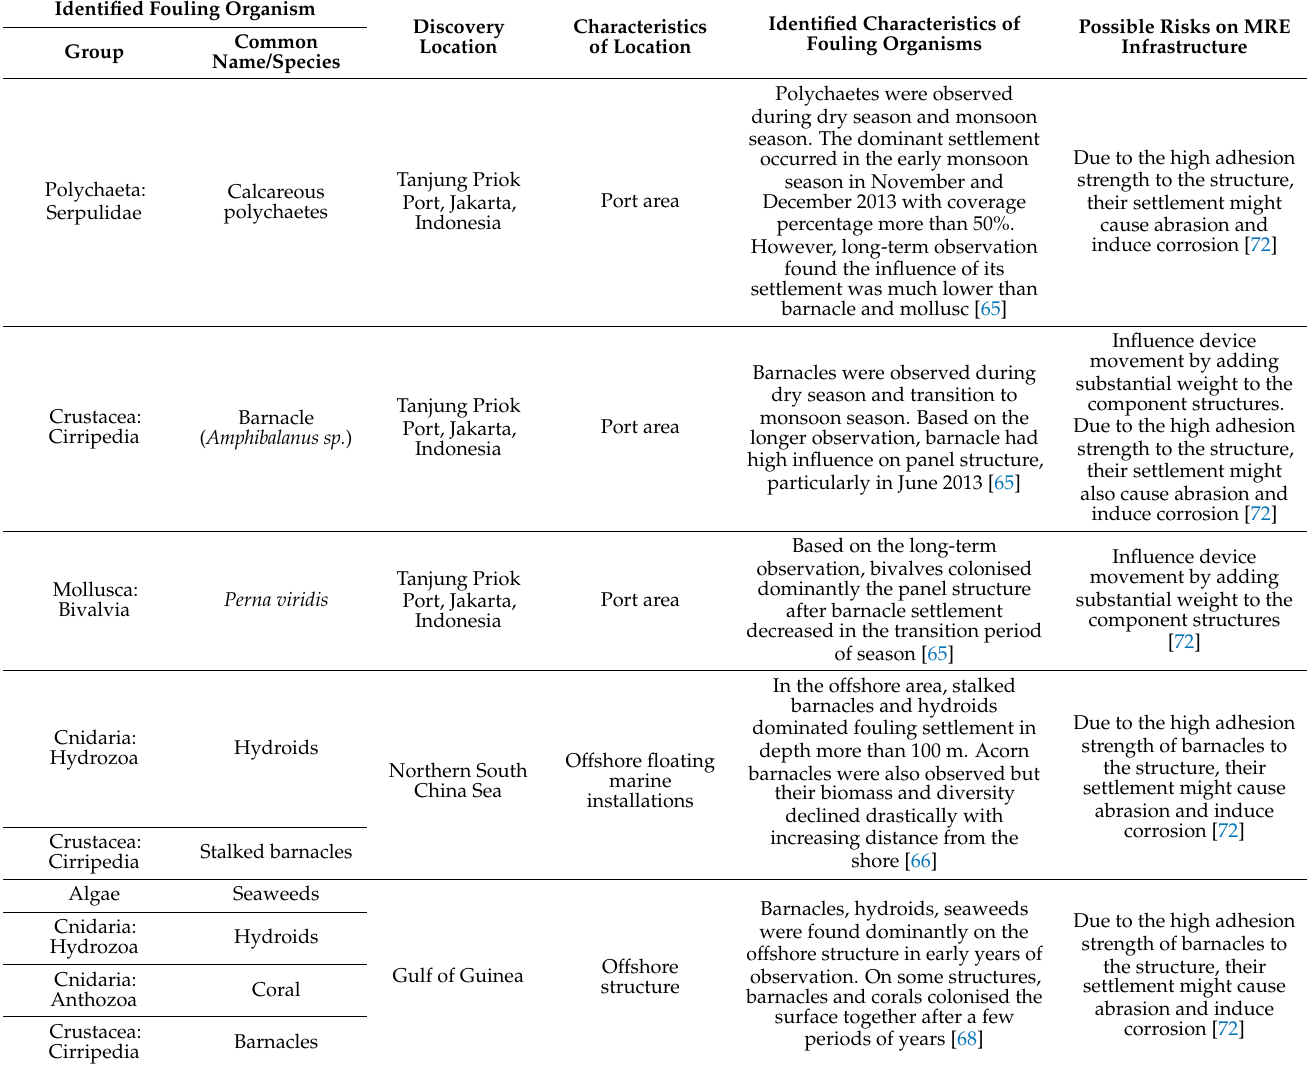
Table 2. Predictive matrix of marine biofouling in tropical waters of Indonesia for MRE case